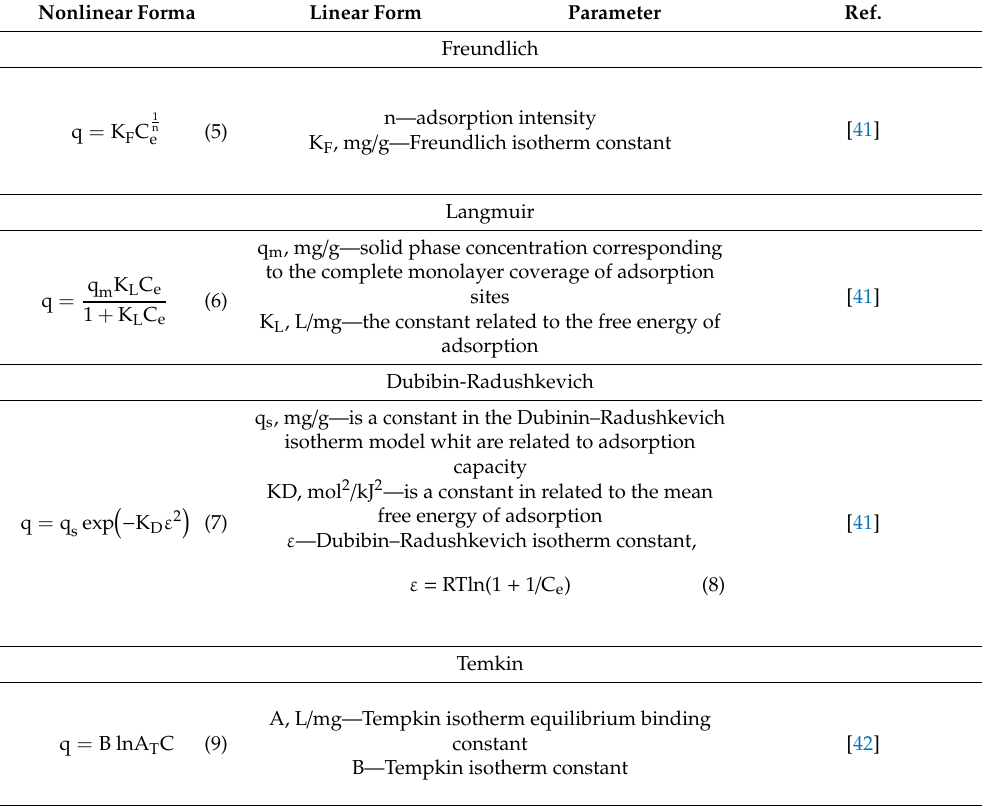
Table 3. Equation of isotherms used in